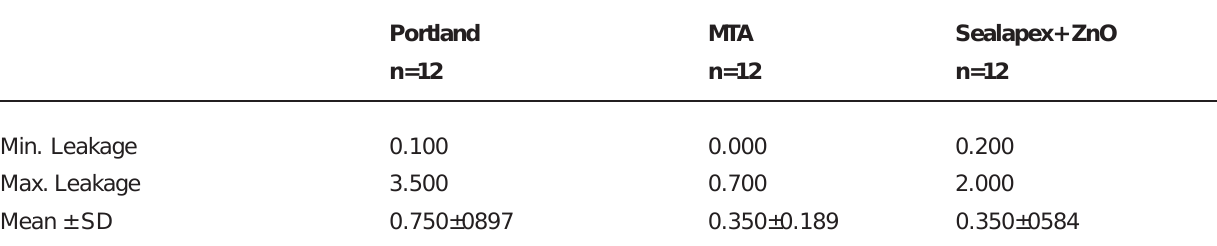
TABLE 1- Mean dye penetration